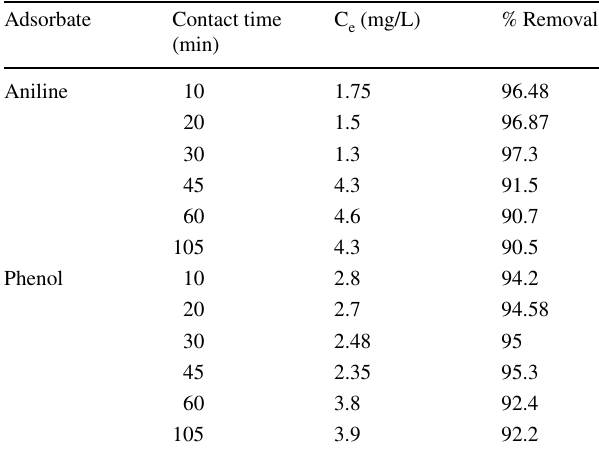
Table 5 Effect of contact time on aniline and phenol removal by ben-